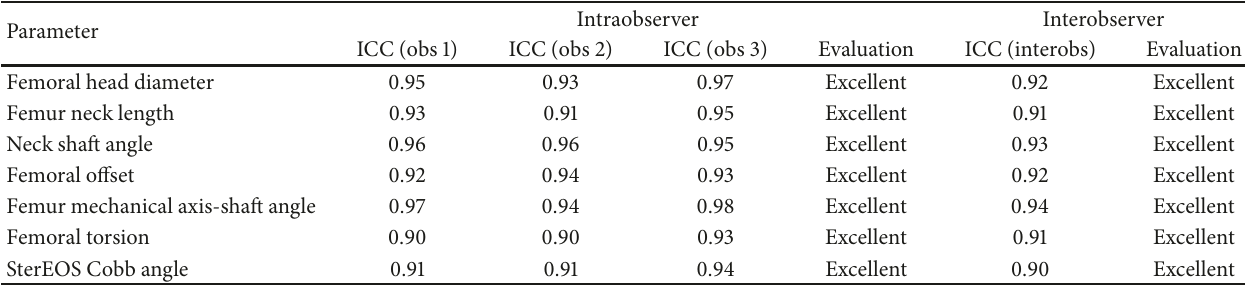
Table 2: Results of the intra- and interobserver reliability study, assessing reliability of EOS reconstructions. Evaluation is as per Winer’s criteria.